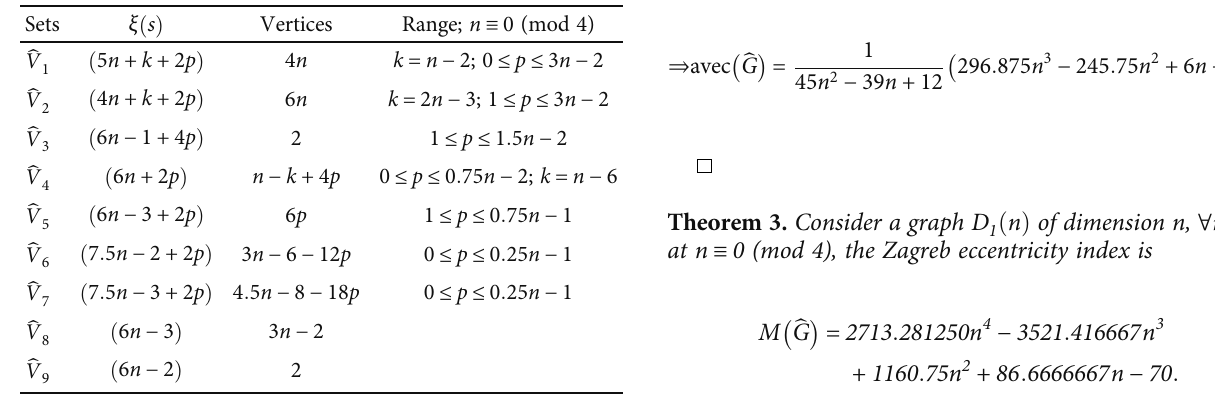
Table 1: Vertex partition of D